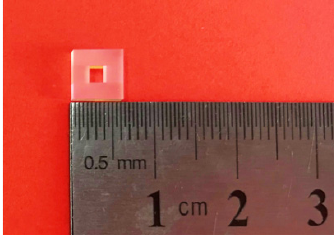
Figure 1. The photograph of the used FPE (Fabry–Pérot